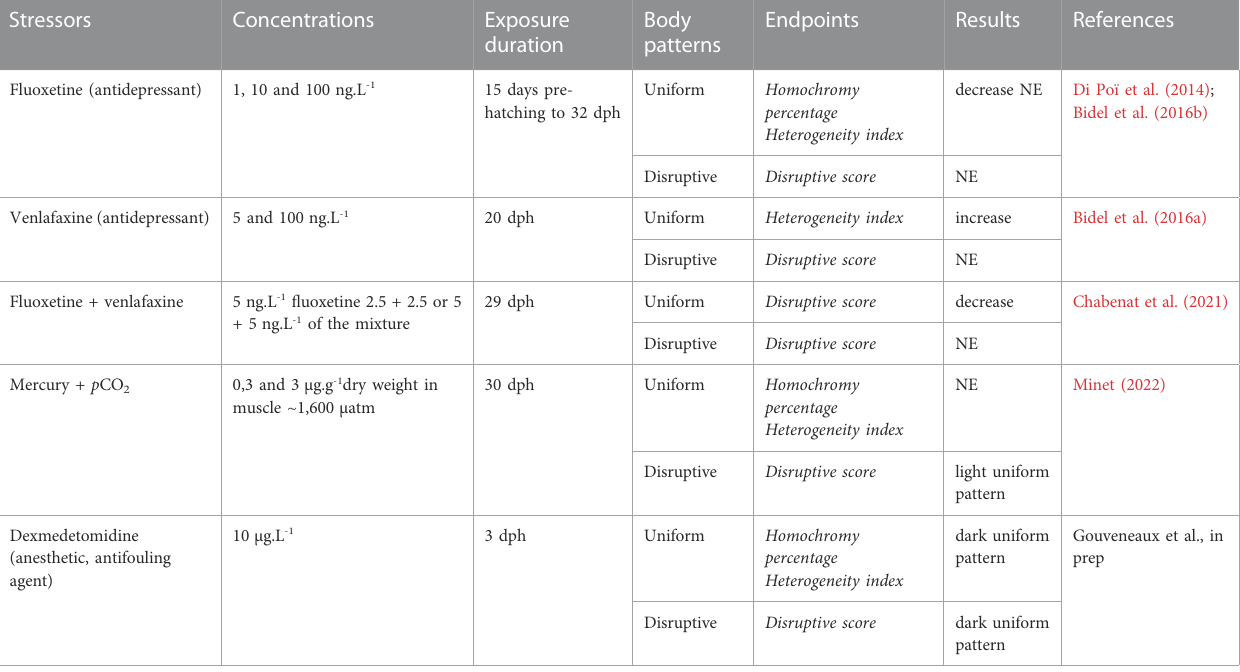
TABLE 1 Summary of uses of body patterns in ecotoxicology (dph: days post-hatching; NE: no effect).